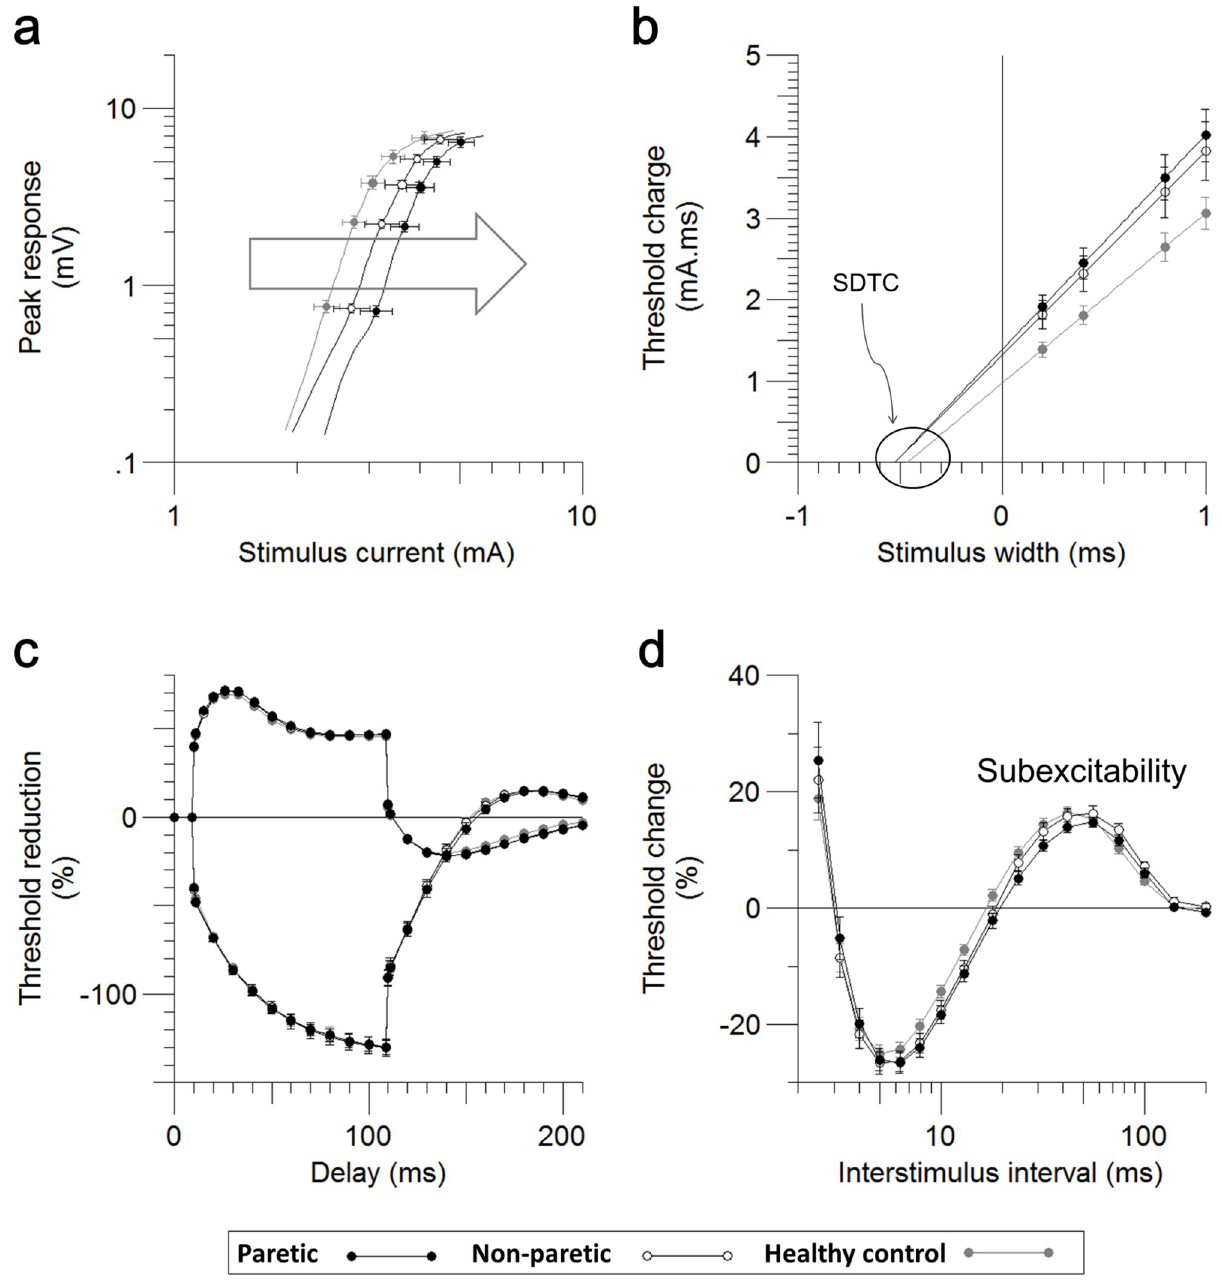
Fig 1. The waveforms of motor axons excitability parameters were presented as mean with SE for the paretic (black, n = 22), non-paretic (white, n = 22) limbs, and the sex and age-matched controls (grey, n = 22). a. Stimulus current for 50% maximal response is higher in paretic limbs than in non-paretic limbs and controls. b. SDTC and rheobase current present significant differences between paretic limbs and controls. c. No differences in the threshold reduction among paretic, non-paretic limbs and controls either in depolarizing or hyperpolarizing conditioning-current stimulation in the acute stage. d. Subexcitability was smaller in the paretic limbs than in non-paretic